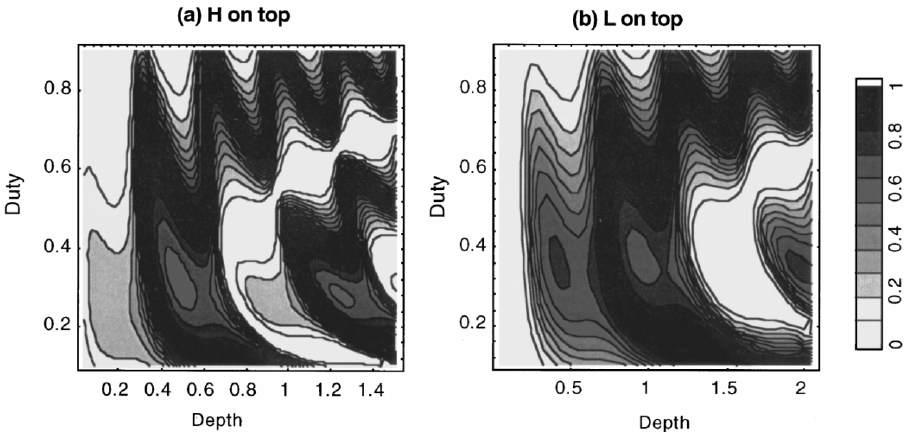
Figure 8. Efficiency versus depth and duty cycle for a quarter ‐ wave HR stack, with grooves etched completely through the top layer. The grating grooves are lamellar, with 1480 grooves/mm, and the duty cycle is 0.3. The wavelength is 1053 nm at a Littrow angle of 51.2°, with TE polarization. The high ‐ index material is hafnia, and the low ‐ index material is silica. The quarter ‐ waves are defined for the wavelength and angle used. ( a ) High ‐ index surface layer over (HL) 7 stack. ( b ) Low ‐ index surface layer over (HL) 7 H stack.